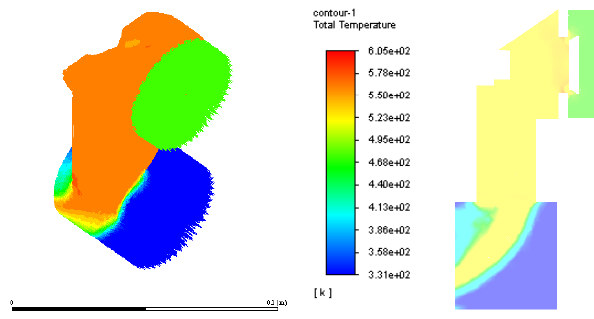
Fig. 14. The total temperature of charge in the EGR valve covered inside by the CD